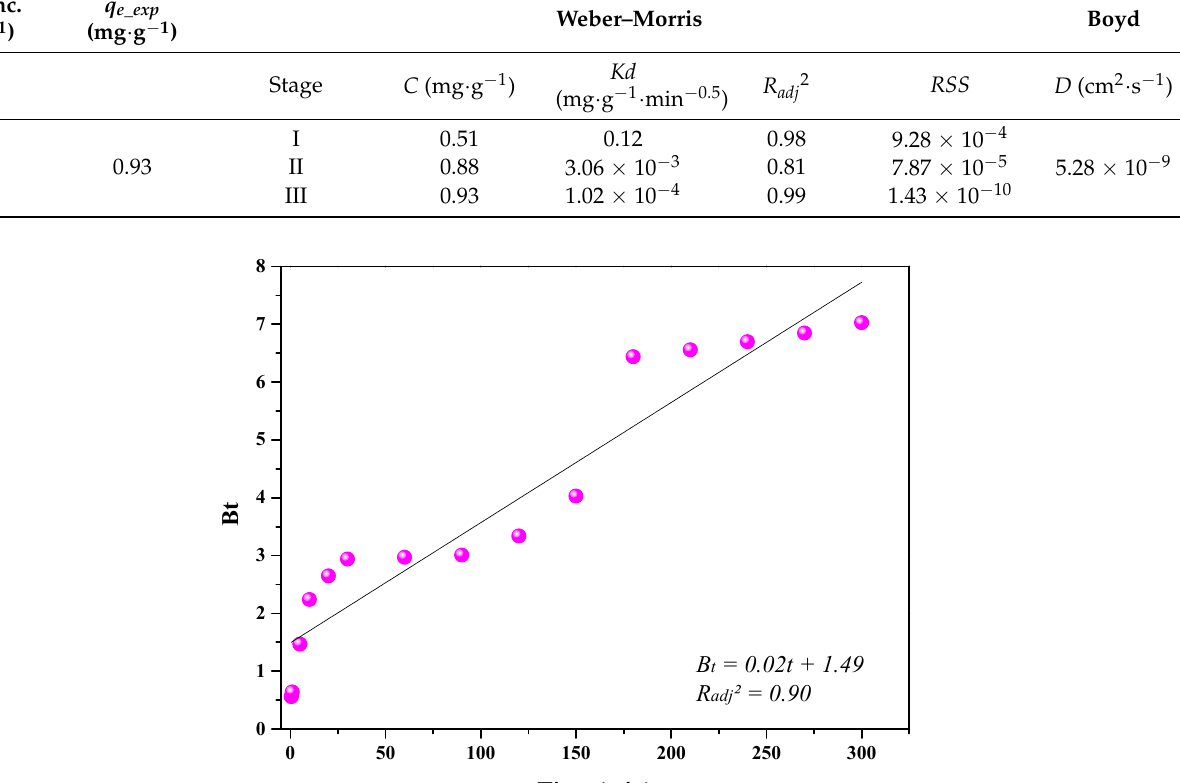
Figure 7. Weber–Morris diffusion model obtained for the treatment of 10 mg · L − 1 MR with 10 g · L − 1 CaSF at 20 °C, stirring the system at 100 rpm. Table 4. Parameters of the Weber–Morris and Boyd diffusion models obtained under optimized conditions. MR Conc.